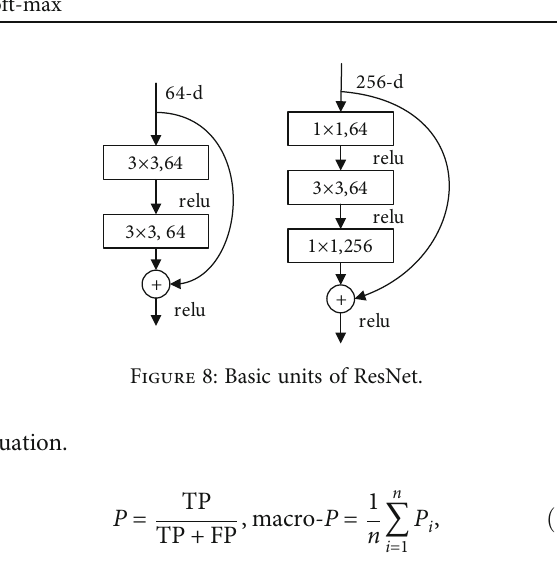
Figure 8: Basic units of